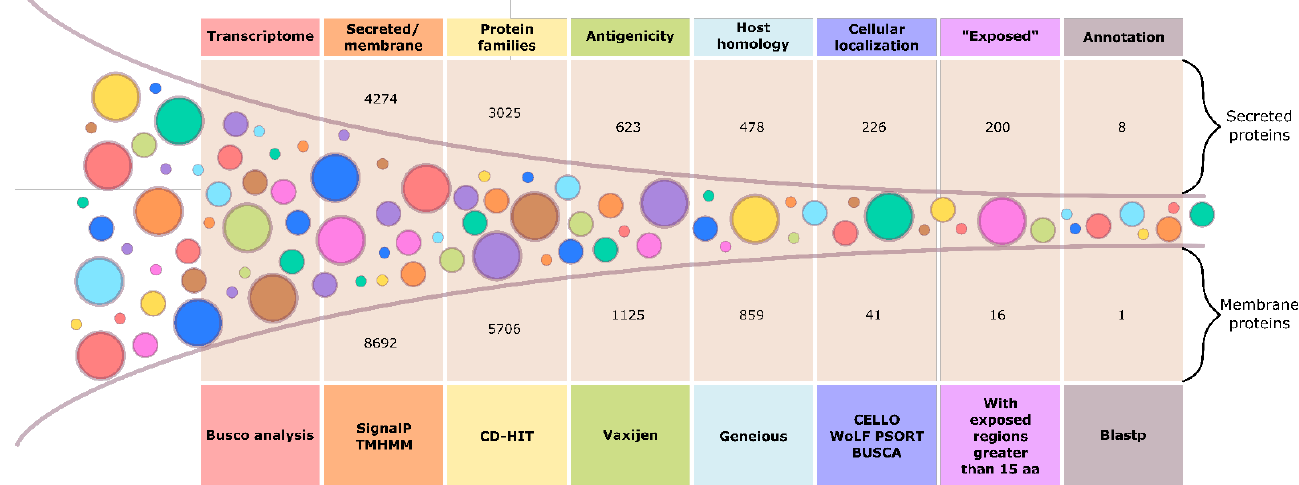
Figure 1. Graphical depiction of the reverse vaccinology (RV)-based methodology used for antigen screening. From the “fed and infected” R. bursa sialotranscriptome dataset, the secretome (secreted proteins) and the surfaceome (membrane proteins) were differentiated using SignalP and TMHMM (software package, standalone installation or online server, current v.2.0.). Several filters were applied using different programs to filter promising targets.